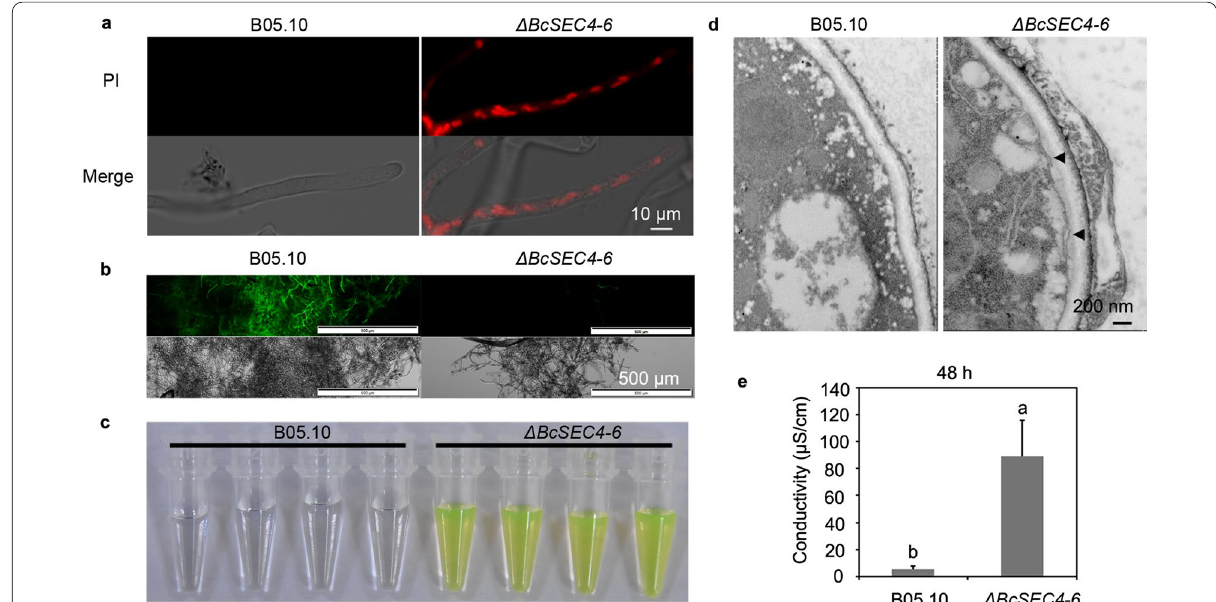
Fig. 6 BcSec4 is required for membrane integrity of B. cinerea . a Plasma membrane integrity of B05.10 and the ΔBcSEC4 mutant assessed by staining with the small molecule propidium iodide (PI). b ROS accumulation assessed by DCFH‑DA staining. c Fluorescence accumulation in the supernatant of conidial suspension. d Transmission electron microscopy observation of the plasma membranes of B05.10 and the ΔBcSEC4 mutant cultured in YEPD liquid medium for 12 h. Arrowhead indicates a site of cell membrane damage. e The conductivity of B05.10 and the ΔBcSEC4 mutant measured after inoculation for 24 h. All data are represented as means standard deviations (SDs) from three independent experiments. Different ± letters indicate statistically significant differences ( P <